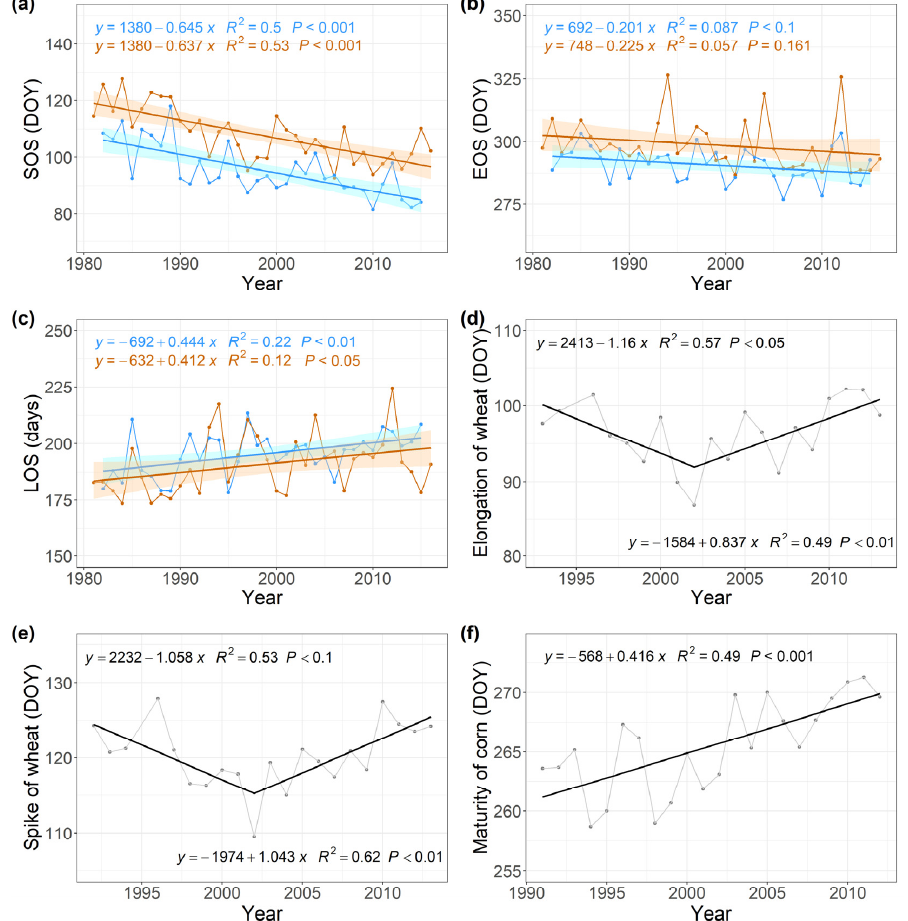
Figure 5. Phenological trends comparison. ( a ) SOS, ( b ) EOS, and ( c ) LOS trends derived from VIP (blue) and GIMMS (brown) over the whole study region. ( d – f ) shows the variation trends of the elongation and spike date of wheat and the maturity date of corn, respectively. DOY means the day of year.